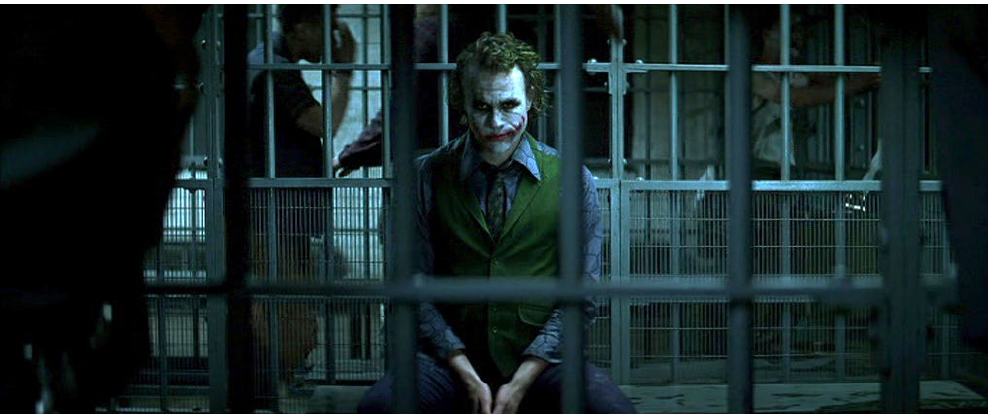
Figure 5 Layered setting simulating the Joker’s layered personas in The Dark